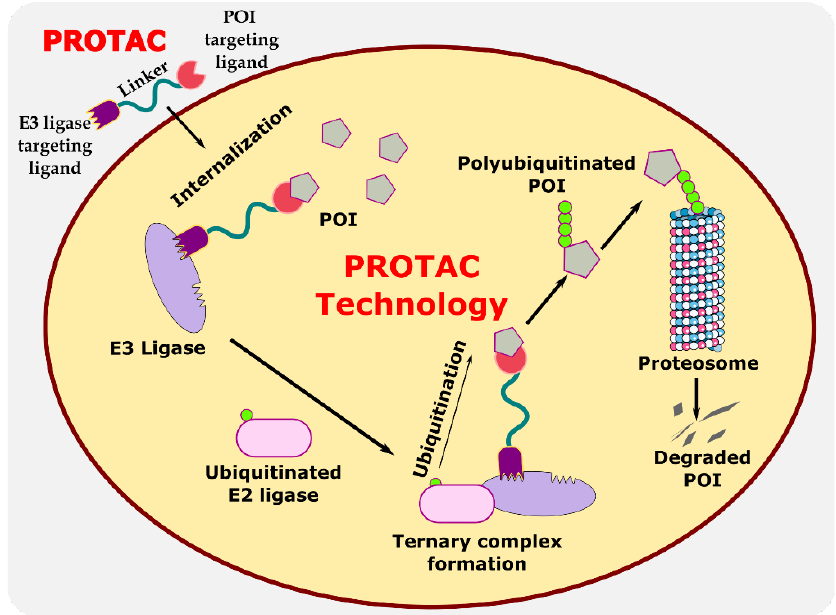
Figure 1. Illustration explaining the mechanism of PROTAC in targeted protein degradation.